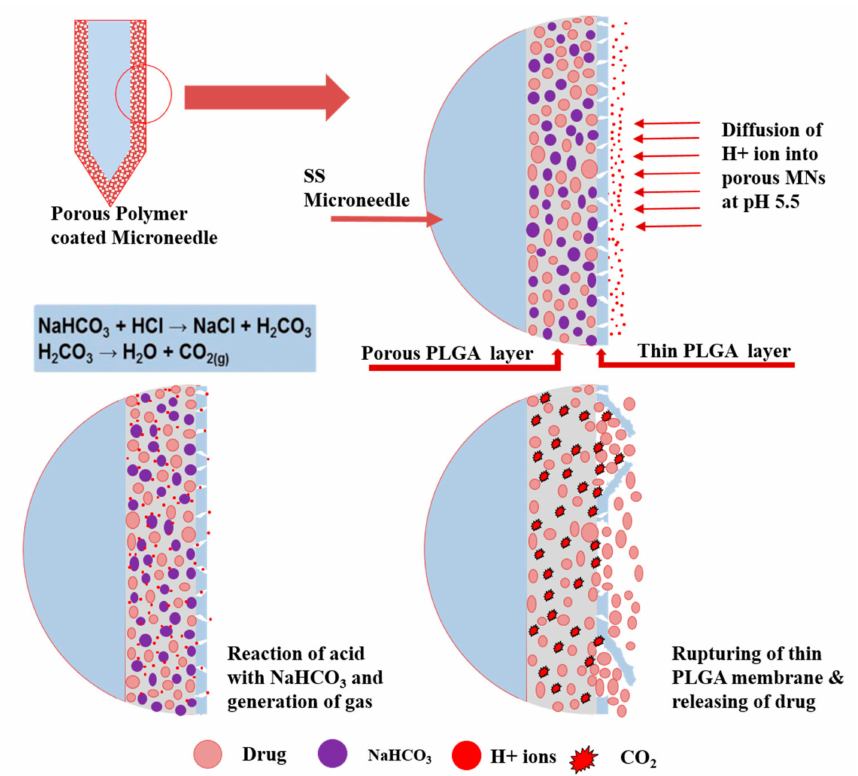
Figure 1. Schematic illustration of the pH-responsive release